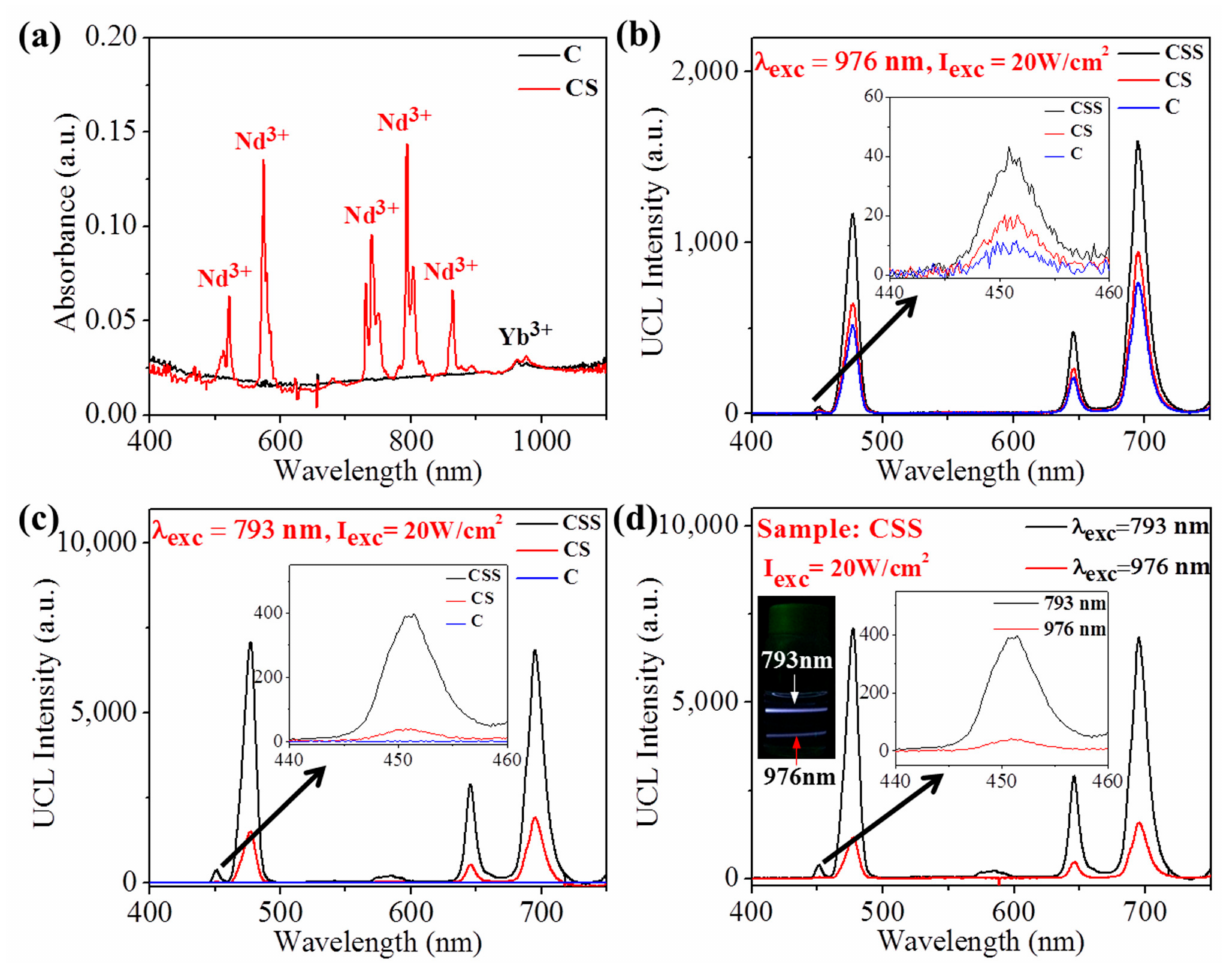
Figure 3. ( a ) UV − VIS − NIR absorption spectra of C and CS UCNPs dispersed into cyclohexane at a concentration of 0.1 mmol/mL. UCL spectra of as − synthesized samples (C, CS, CSS) in the wavelength range of 400–750 nm under ( b ) 976 nm excitation and ( c ) 793 nm excitation. Insets show UCL emission spectra of these samples in the wavelength range of 440–460 nm. ( d ) UCL emission spectra of the CSS sample under the excitation at 793 and 976 nm, inset shows its enlarged view in the wavelength range of 440–460 nm and a photograph of the CSS sample under the excitation of two parallel narrow beams at 793 and 976